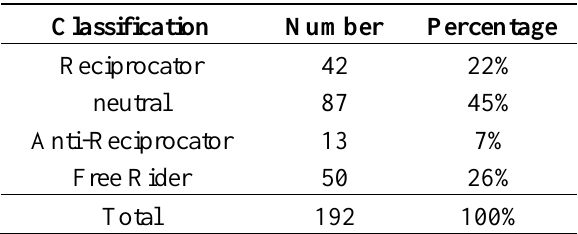
Table 2. Classification of response